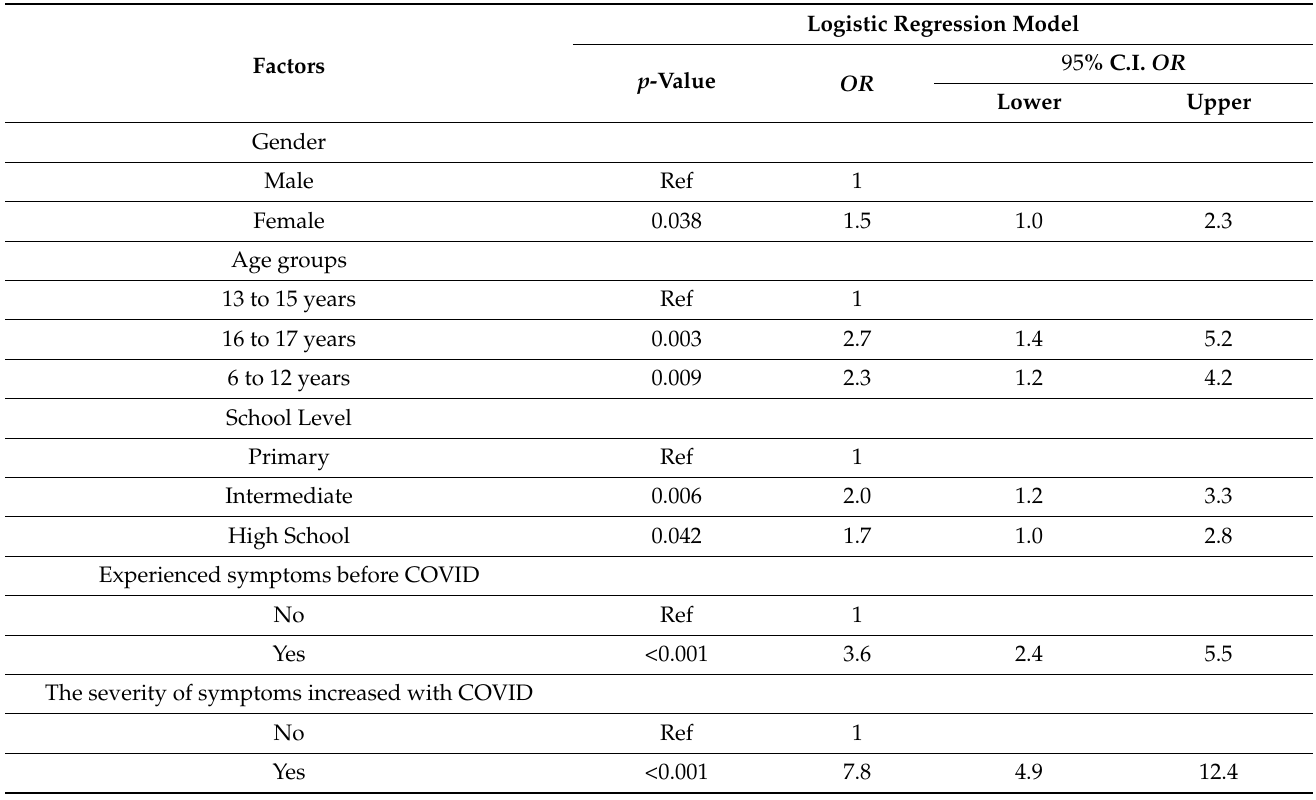
Table 3. Logistic regression analysis of risk factors of CVS among the